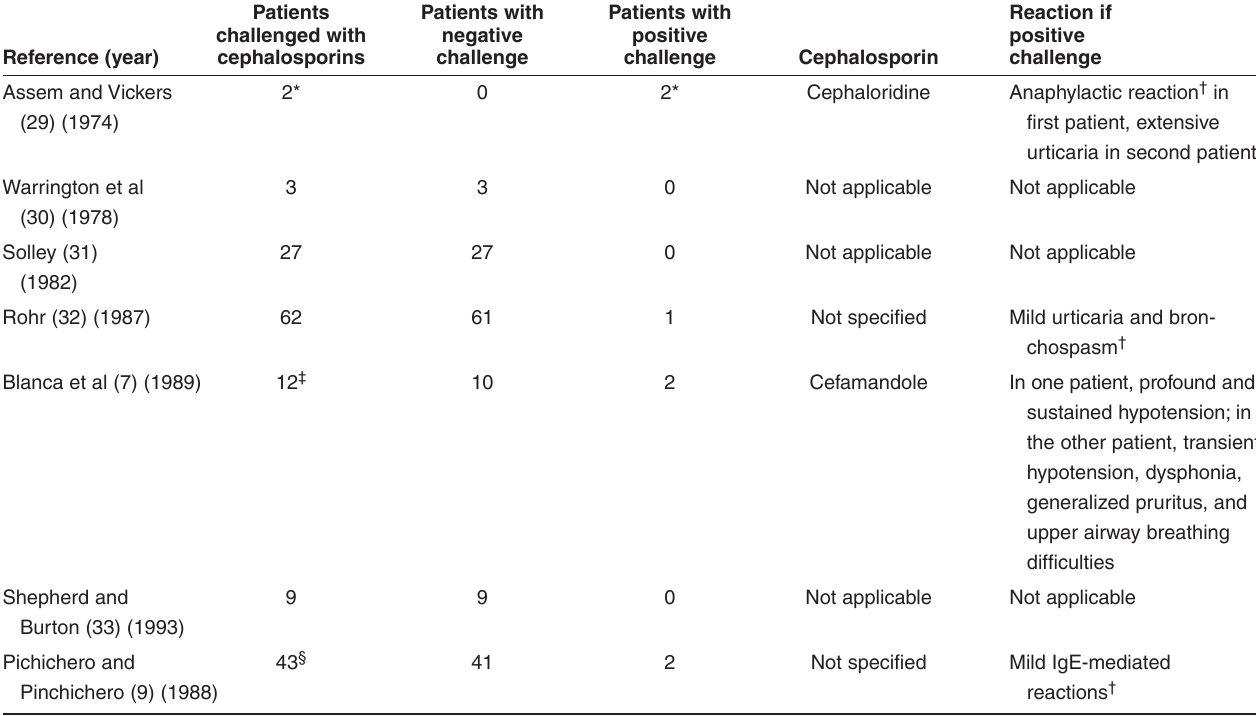
TABLE 2 Summary of studies of cephalosporin challenge in patients with positive skin tests for allergies to